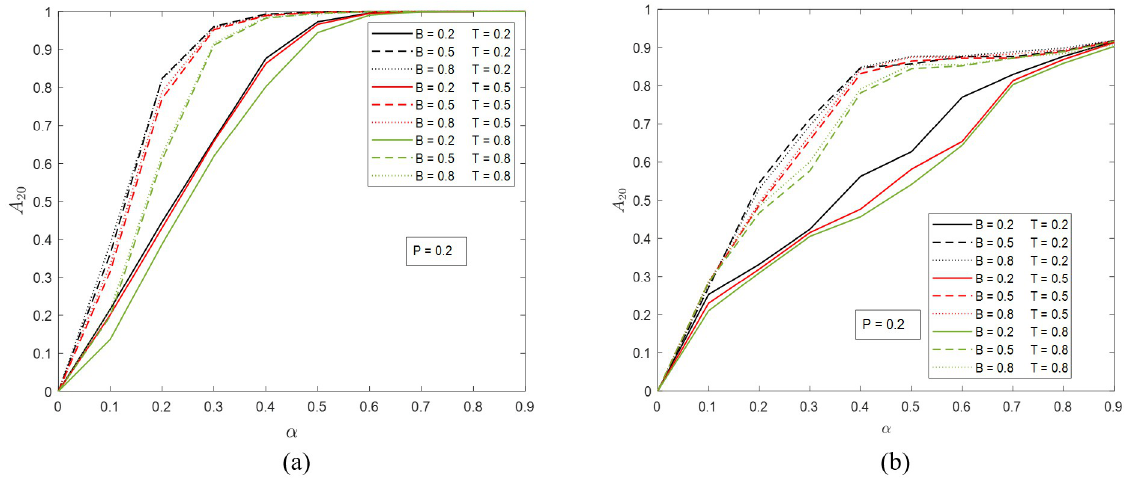
Fig 4. The portion of active nodes at time step 20 when P = 0.2 in (a) the ER network and (b) the SF network. The possible values of B and T are 0.2, 0.5, and 0.8. The values of α are from 0 to 0.9 at step size